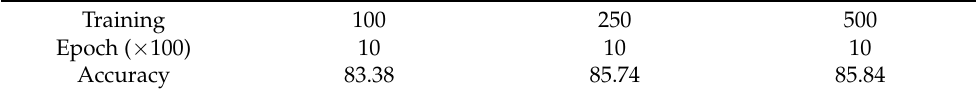
Table 8. Mask R-CNN Face Detection Accuracy (mAP = 0.5, Testing sets = 160).